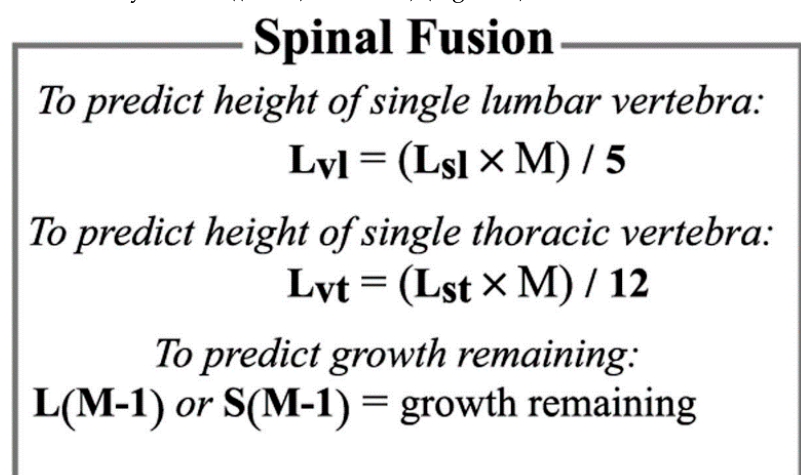
Figure 5. Equation for predicting height of the single lumbar and thoracic vertebrae and remaining growth. L, age-specific length; Lsl, age-specific length of lumbar spine; Lst, age-specific length of thoracic spine; Lvl, length of single lumbar vertebra at maturity; Lvt, length of single thoracic vertebra at maturity; M, age-specific multiplier; S, age-specific sitting height.